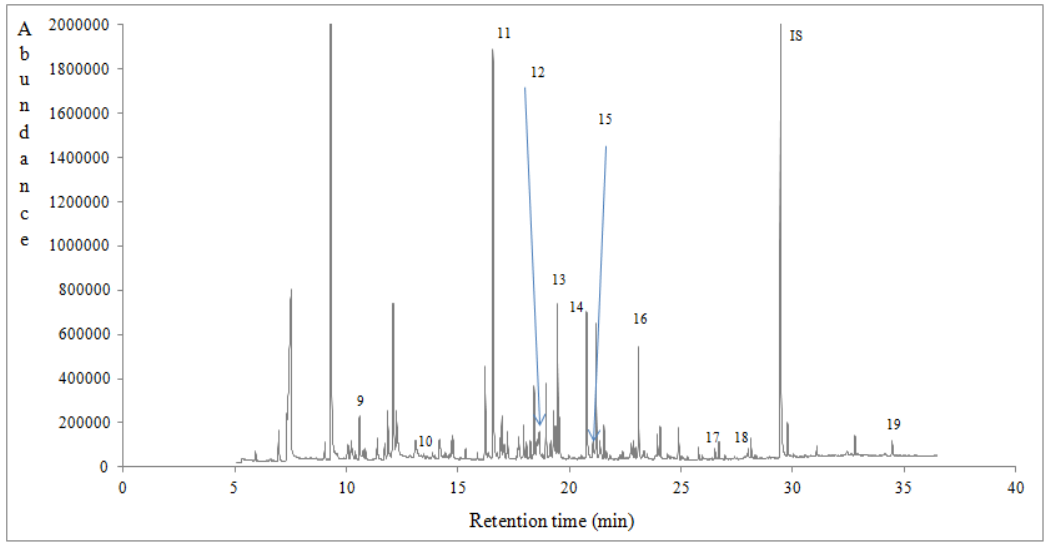
Figure 2. A typical gas chromatogram of chestnut honey from the region of Braganca, Vinhais, in Portugal. 9: 2-methyl-2-Butenal. 10: 3-methyl-butanoic acid ethyl ester. 11: Benzaldehyde. 12: 2-hydroxy-Benzaldehyde. 13: Nonanal. 14: 1-Nonanol. 15: Benzoic acid ethyl. 16: Nonanoic acid ethyl ester. 17: 2,6-bis-(1,1-trimethyl)-2,5-cyclohexadiene-1,4-dione. 18: Dodecanoic acid ethyl ester. 19: Hexadecanoic acid ethyl ester. IS: Internal standard.